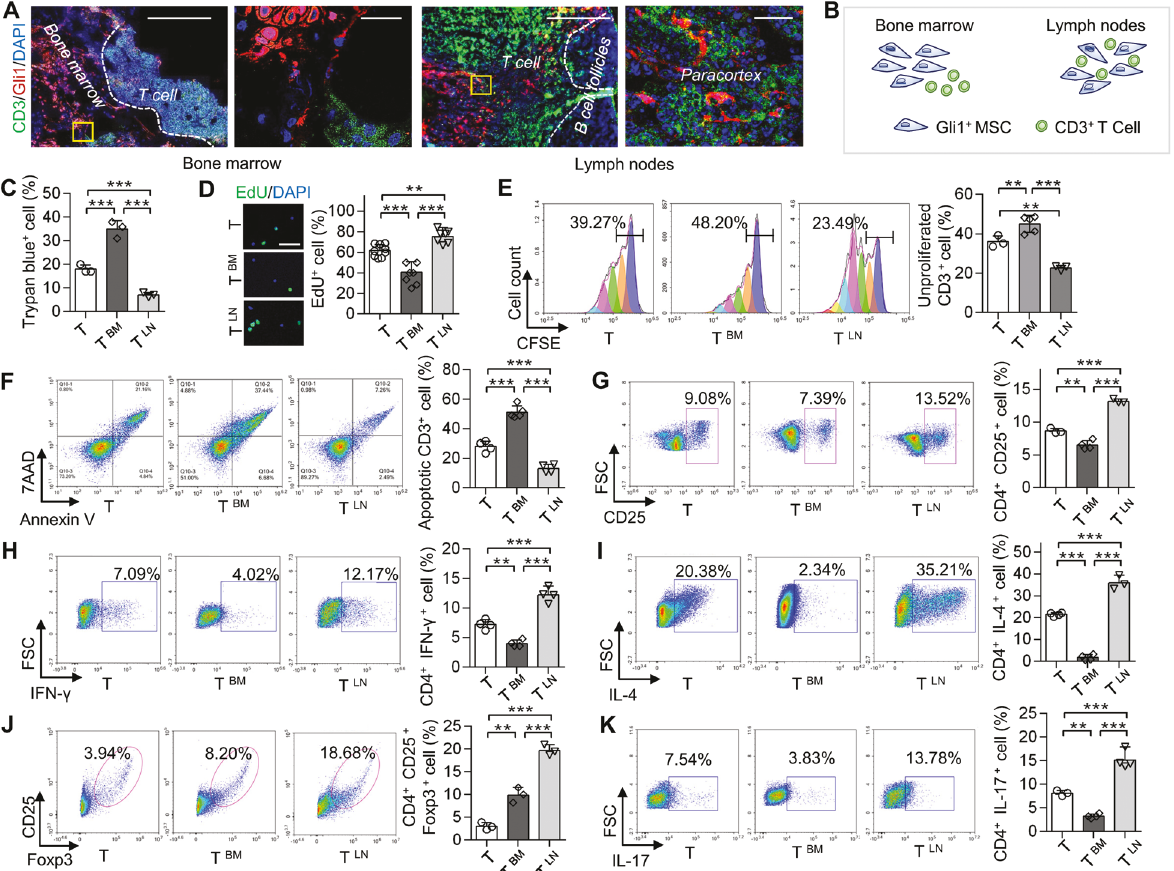
Fig. 1 Immunosupportive effect of LNMSCs. A The distribution of Gli1-positive MSCs in the lymph nodes and bone marrow of Gli1-Cre ERT2 ; R26 tdTomato mice. Scale bars = 200 μ m for lower magni fi cation and 20 μ m for higher magni fi cation. B Schematic fi gure of the distribution of Gli1-positive MSCs in mouse lymph nodes and bone marrow. C Live-cell counting of trypan blue-positive T cells after co-culture with LNMSCs and BMMSCs. n = 3. D , E CFSE analysis and EdU staining showed that LNMSCs promote activated T-cell proliferation. Scale bar = 50 μ m. n = 7 – 9 ( D ), n = 3 – 5 ( E ). F Flow cytometry analysis showed the anti-apoptotic effect of LNMSCs on activated T cells. n = 4 – 5. G Flow cytometry analysis showed that LNMSCs stimulate CD4 + T-cell activation. n = 3-4. H – K Flow cytometry analysis showed that LNMSCs and BMMSCs regulated T-cell differentiation. n = 4 (H), n = 3 – 4 ( I ), n = 3 ( J ), n = 3 – 4 ( K ). * P < 0.05, ** P < 0.01, *** P <